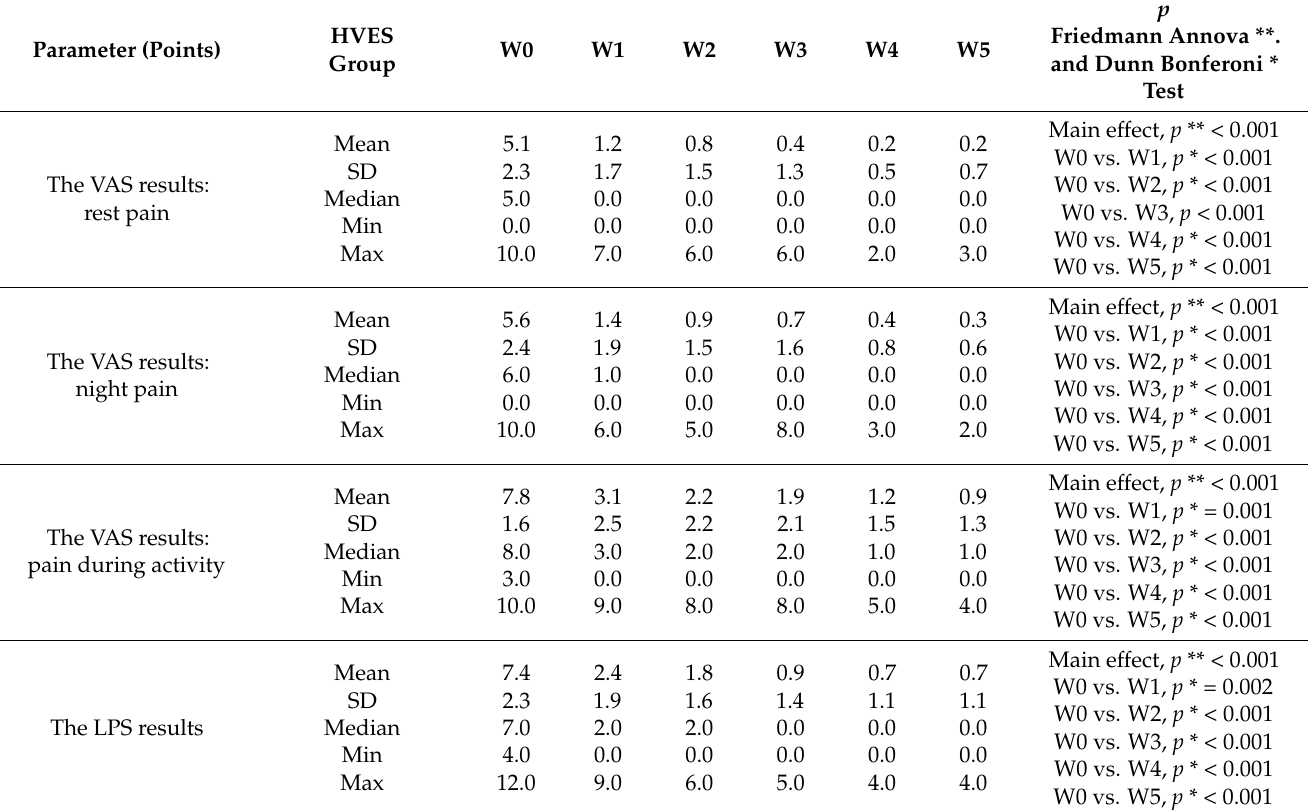
Table 5. The VAS and LPS results of within-group HVES at treatment (points). Abbreviations: W0, baseline (before treatment); W1, after treatment; W2, 3 weeks after treatment; W3, 6 weeks after treatment; W4, 12 weeks after treatment; W5, 24 weeks after